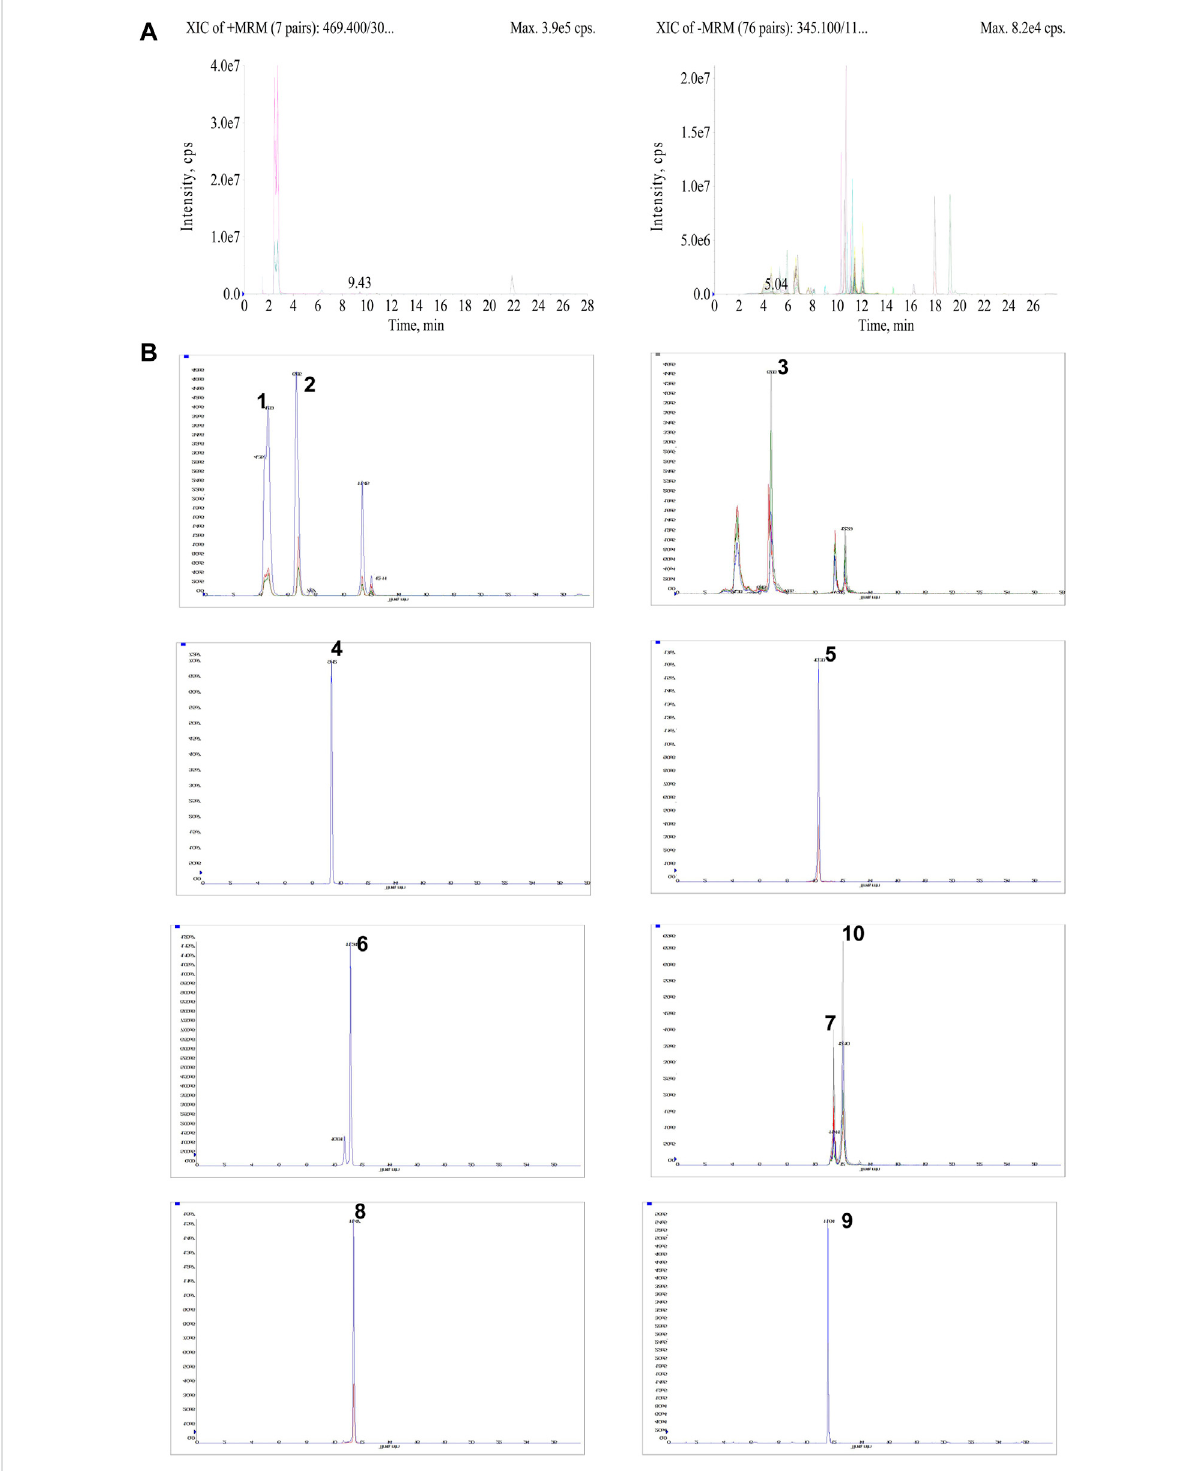
FIGURE 2 Qualitative analysis of AESS in rats serum samples. (A) UPLC-MS/MS chromatograms of drug-containing serum in positive and negative ion mode. (B) The extracted ion chromatograms of 10 compounds in AESS serum